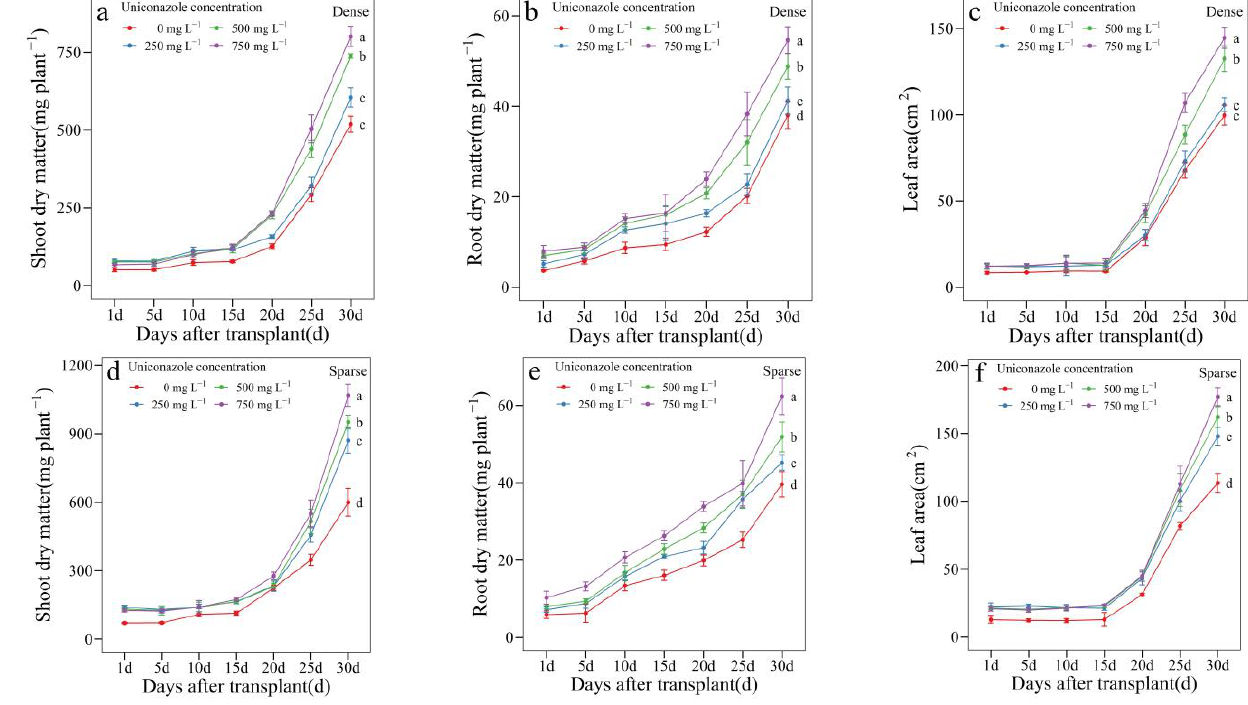
Figure 6. The growth of seedlings after transplant to pots for 30 days. Values are the seedlings sown at dense or spare density of shoot dry matter ( a , d ), root dry matter ( b , e ), and leaf area ( c , f ) during the 30 days after transplanting. Spare and dense represent sowing densities of 400 and 800 seeds per tray, respectively. Significant effects ( p ≤ 0.05) are shown by different letters in the same sowing density at 30 d.